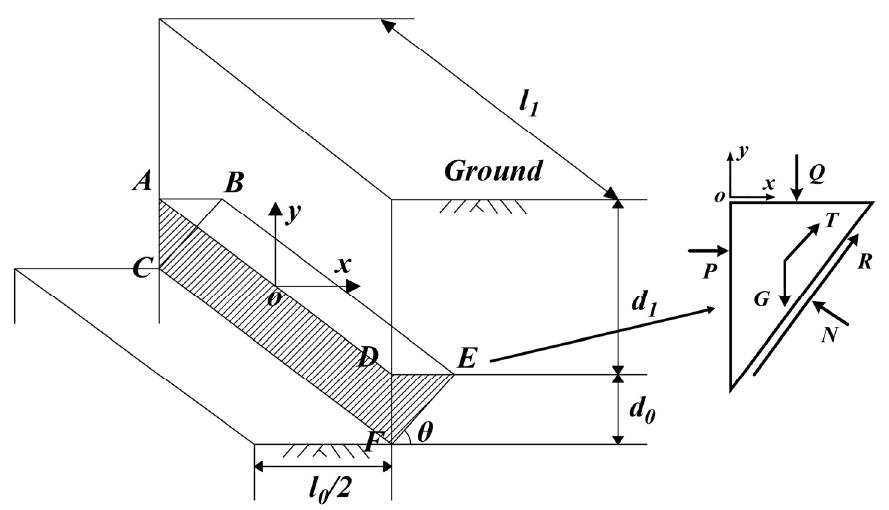
Figure 8. The local failure model of the slot at the diaphragm